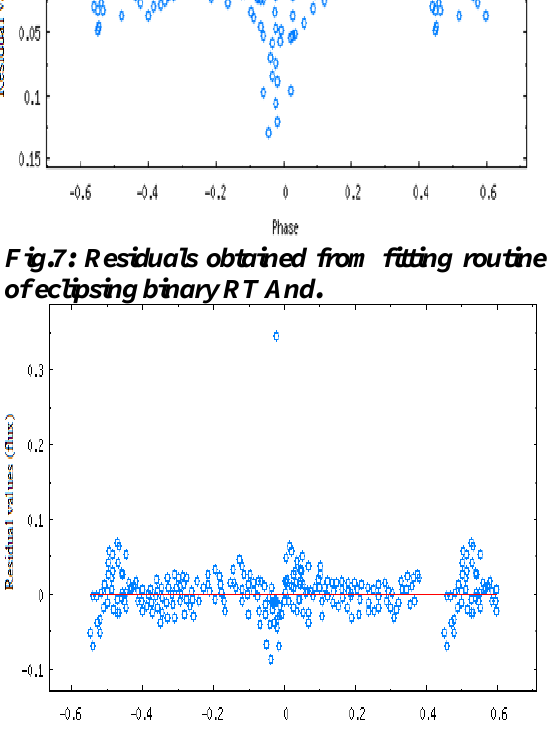
Fig.8: Residuals obtained from fitting routine of eclipsing binary BH Vir.